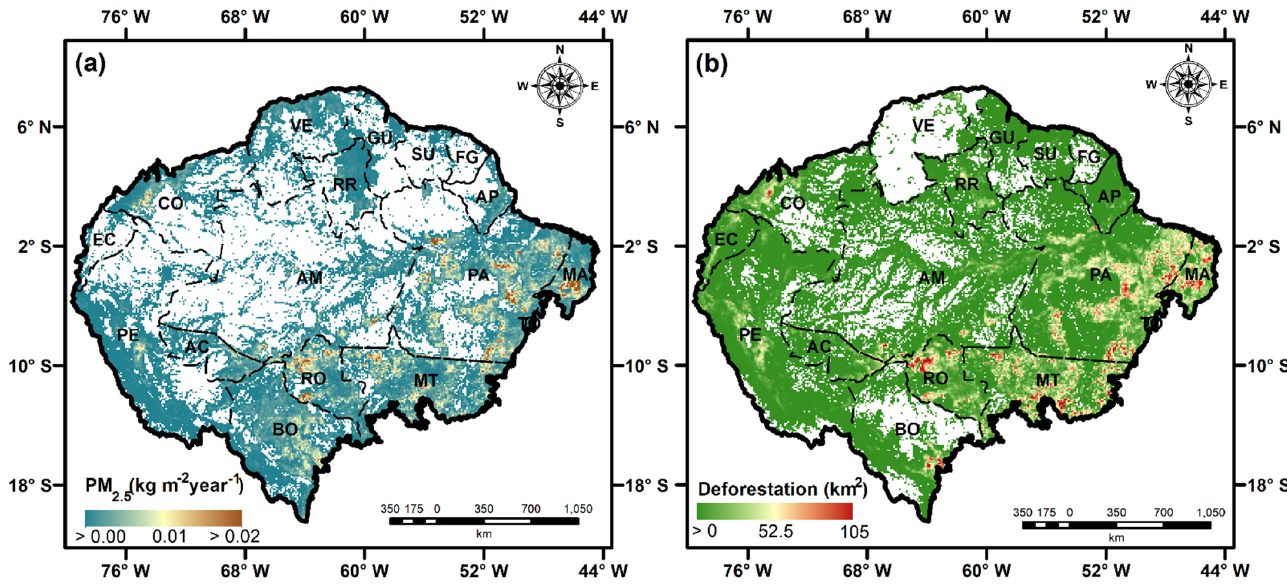
Figure 2. ( a ) Annual average of PM 2.5 (kg m − 2 year − 1 ) emitted from biomass burning in Amazonia during 2002–2020; estimates were obtained using the 3BEM_FRP model, and ( b ) accumulated deforestation (km 2 ) from 2002 to 2018 in Amazonia; estimates were based on MapBiomas Amazonia Collection 2.0. Both estimates considered the spatial resolution of 0.1°. Zero emission or deforestation grid cells are shown in white. BO = Bolivia, CO = Colombia, EC = Ecuador, FG = French Guiana, GU = Guiana, PE = Peru, SU = Suriname, VE = Venezuela, AC = Acre, AM = Amazonas, AP = Amapá, MA = Maranhão, MT = Mato Grosso, RO = Rondônia, RR = Roraima, PA = Pará and TO = Tocantins.